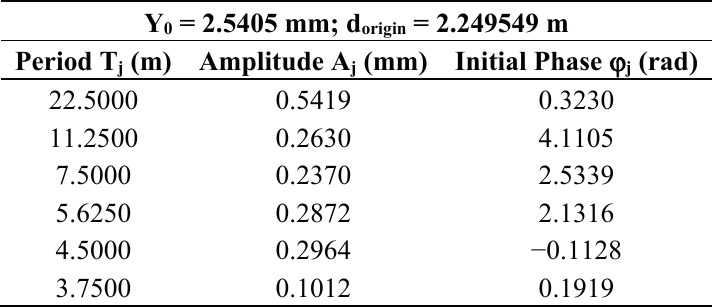
Table 13. Parameters of the correction function–Topcon GPT-7501.